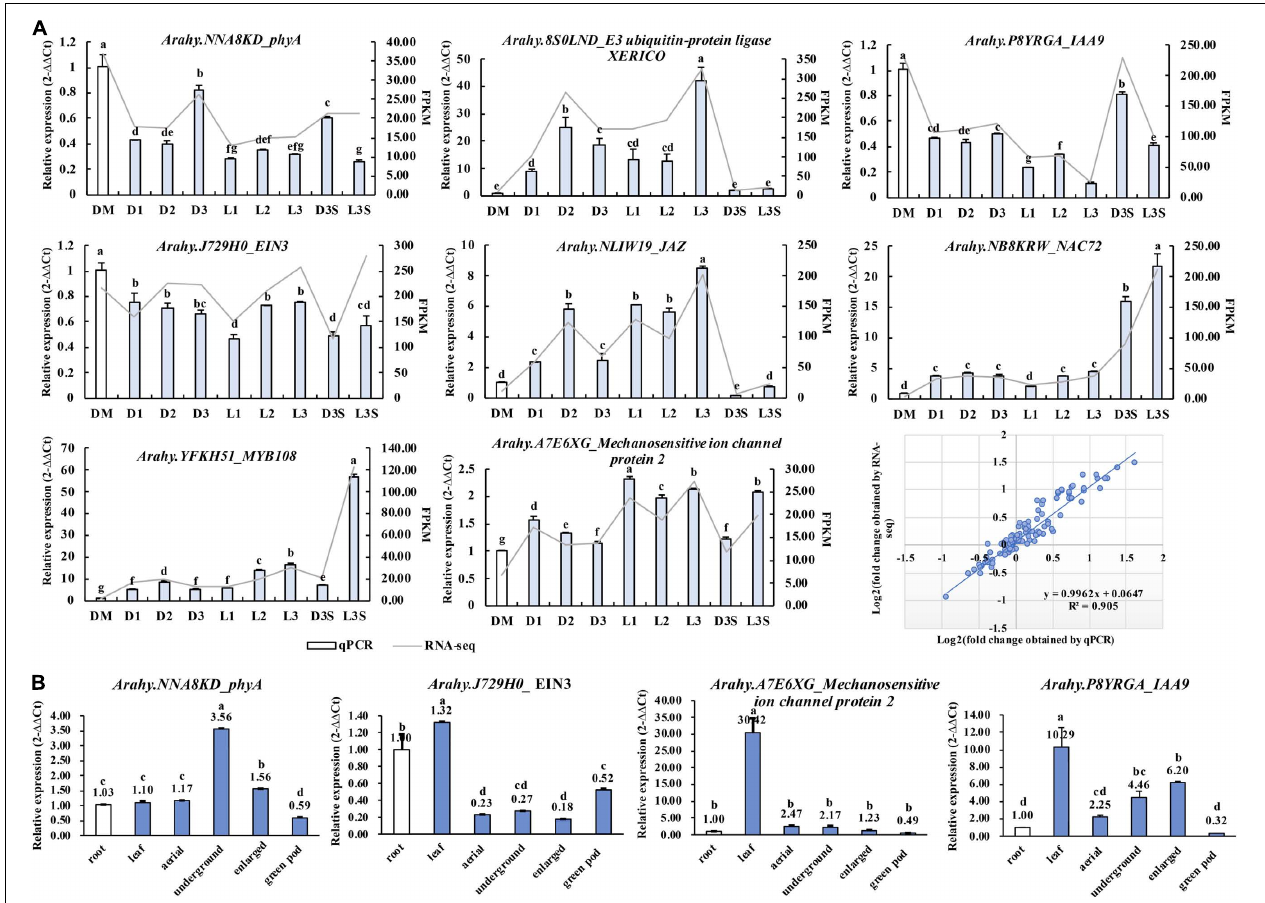
FIGURE 7 | qRT-PCR validation of key genes identified in the transcriptome. (A) Validation of the RNA-Seq results by qRT-PCR; (B) qRT-PCR detecting the expression of key genes in the root, leaf, aerial peg, underground peg, enlarged pod, and exposed green pod. Different lowercase letters indicate a significant difference at p ≤ 0.05 (Duncan’s multiple range